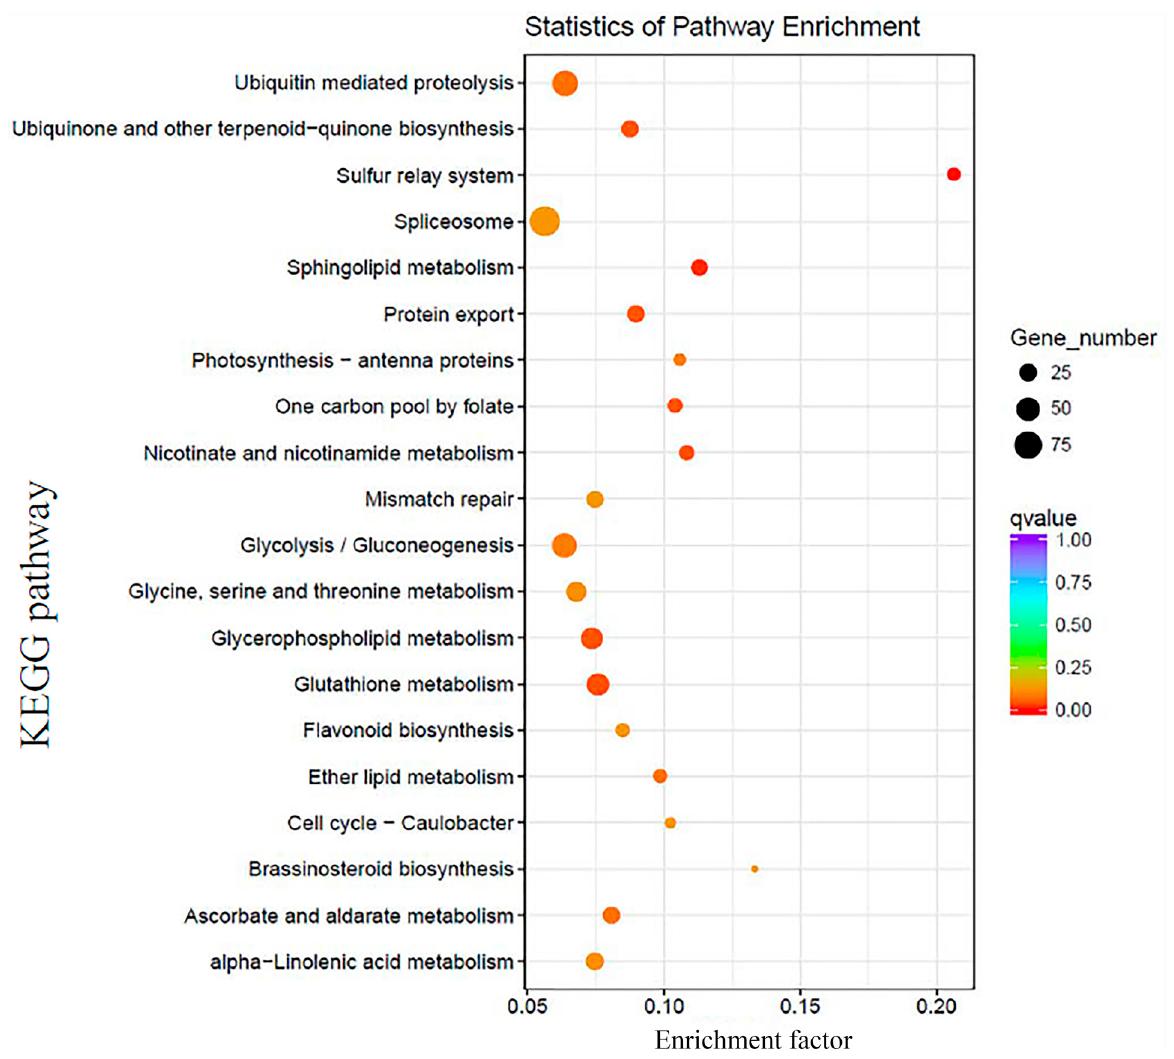
Figure 9. KEGG enrichment target genes in M. sativa SE.